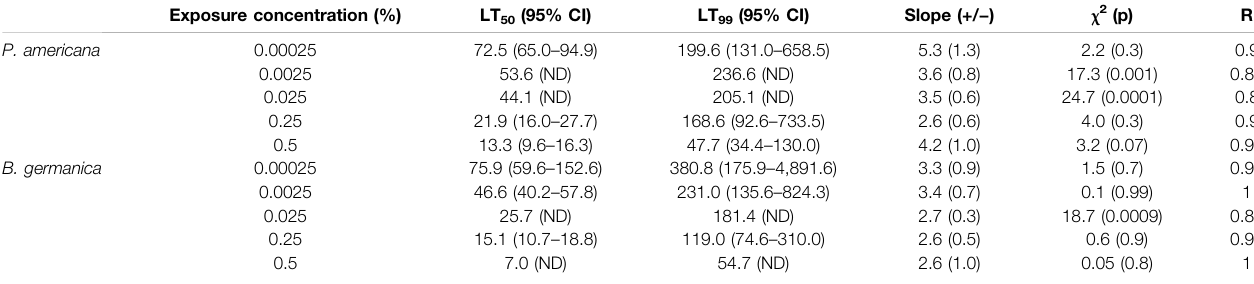
TABLE 4 | Lethal time (LT) values of P. americana and B. germanica for different concentration of deltamethrin exposure. Exposure concentration (%)